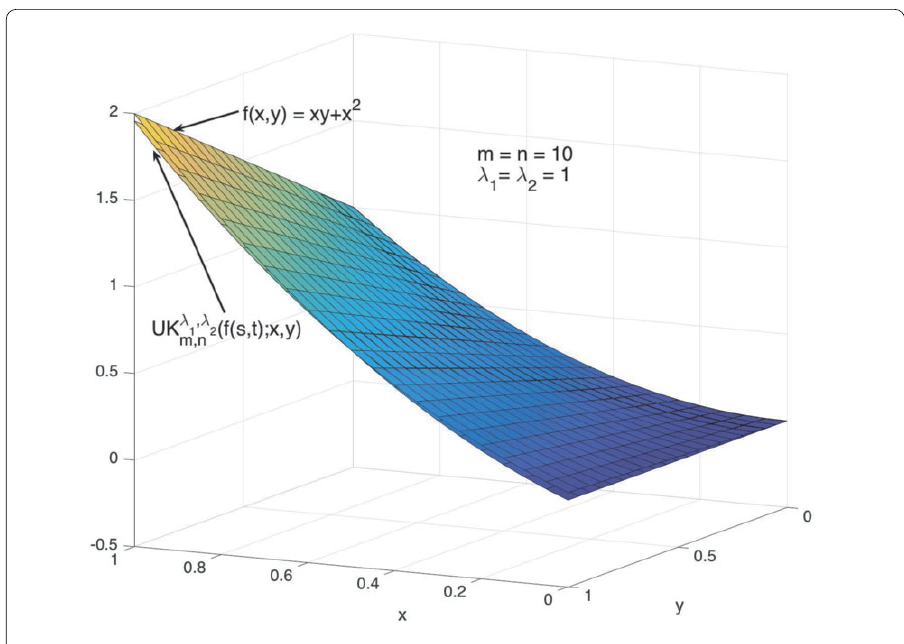
Figure 1 Graphs of UK 1,1 10,10 ( f ( s , t ); x , y ) and f ( x , y